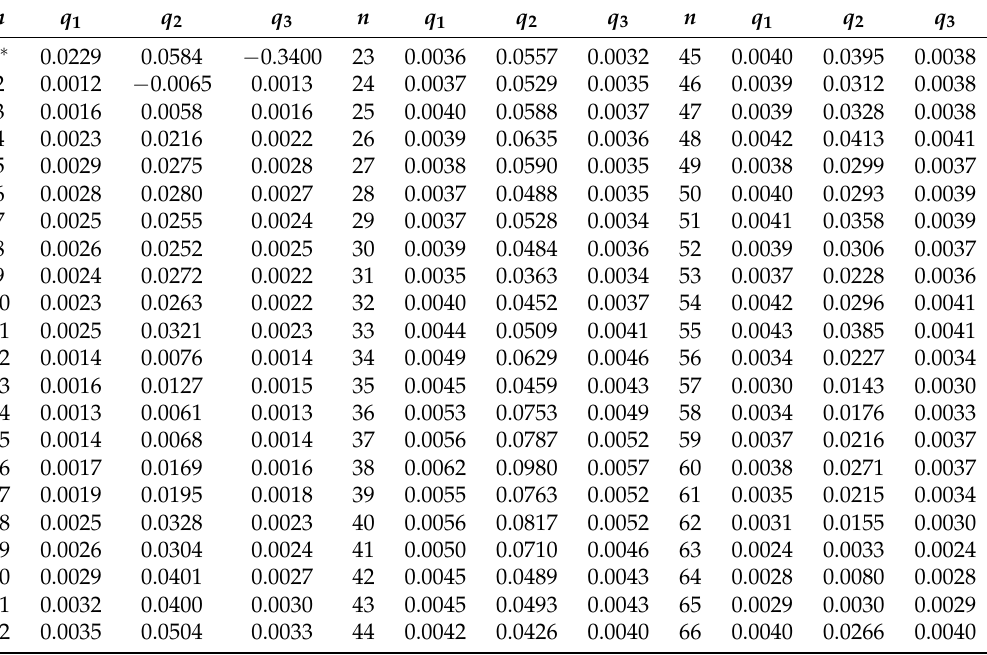
Table C4. The coefficients for the fitting function of P fix against P f , ILS . The tolerable failure rate is = 0.001. The function is shown in Equation (14). Note ∗ q P tol f